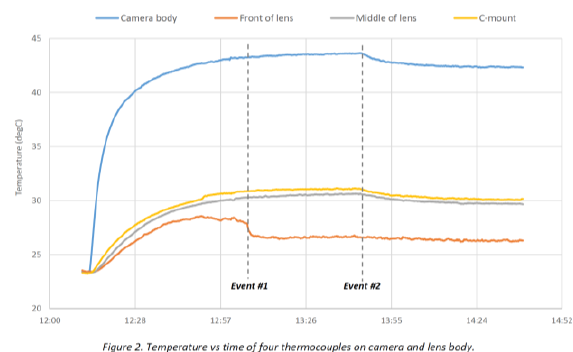
31.0°C and 30.5°C respectively.